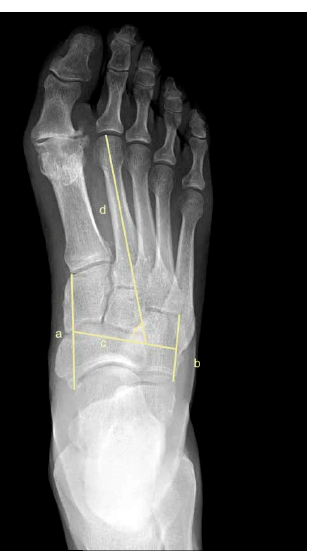
Figure 8. Dorsoplantar weightbearing radiograph of Kilmartin’s angle. Modified Kilmartin’s angle [14], Figure 9, is the angle measured between the longitudinal axis of the second metatarsal and the transverse axis of the lesser tarsus. Line (a) extends between the most medial point of the talo-navicular and the medial cuneiform-first metatarsal joints. Line (b) extends between the most lateral point of the 4th metatarso-cuboid and the calcaneo-cuboid joints. Line (c) extends between the midpoints of lines (a) and (b). Line (d) represents the longitudinal axis of the second metatarsal bone. Modified Kilmartin’s angle is the angle between lines (c) and (d).